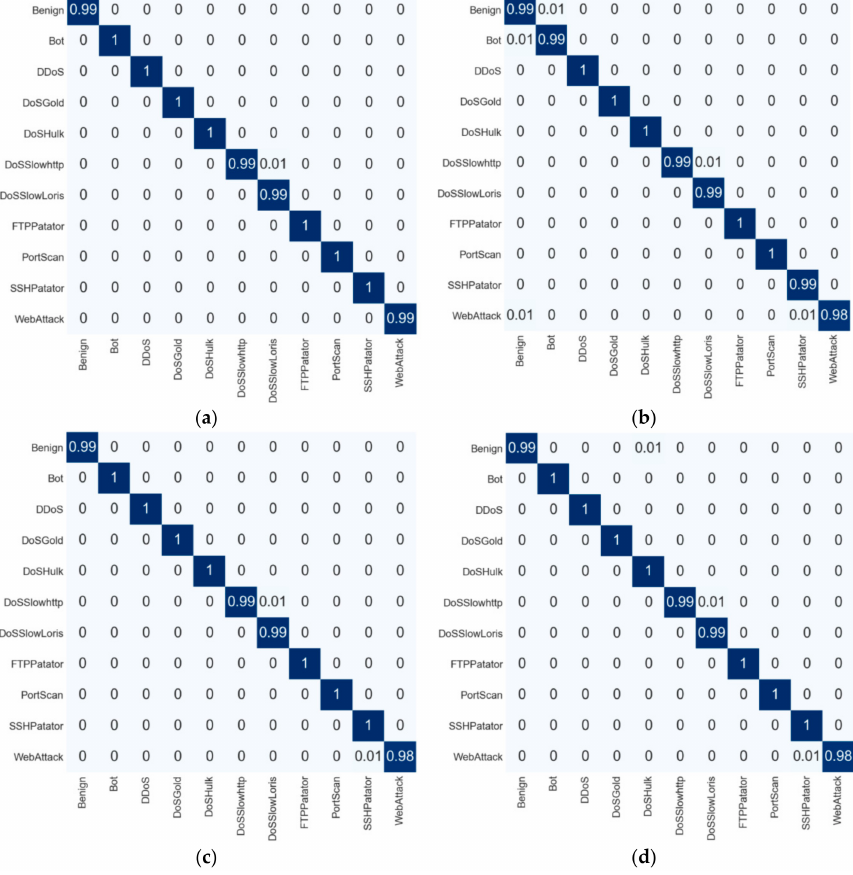
Figure 5. Confusion matrix of the CIC-IDS 2017 dataset: ( a ) proposed process flow, ( b ) standard process flow, ( c ) SFS-DT-based feature selection, and ( d ) SBS-DT-based feature selection.